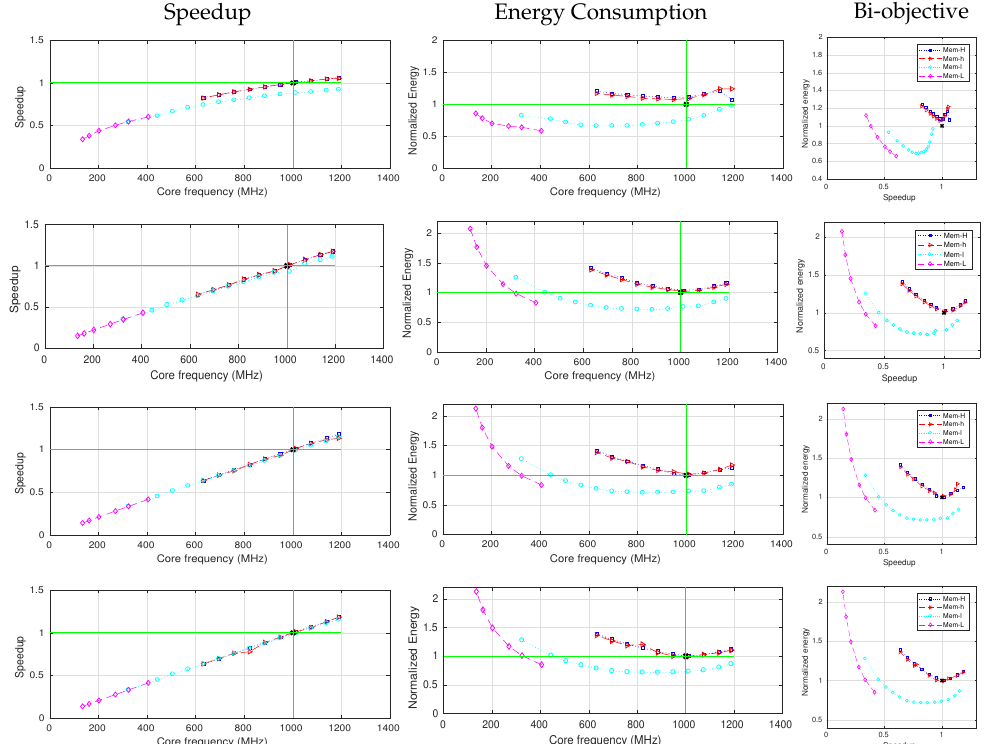
Figure 10. Matrix multiply results with different memory and core frequency in different input sizes (8192, 262,144, 524,288 and 1,048,576 from top to bottom).